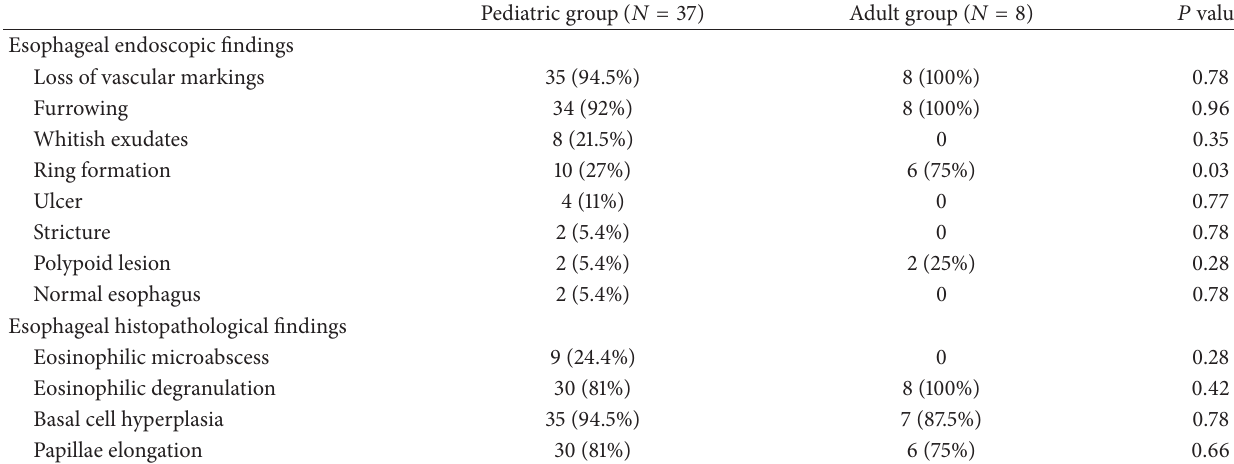
Table 3: Endoscopic and histopathological features of 45 patients with eosinophilic